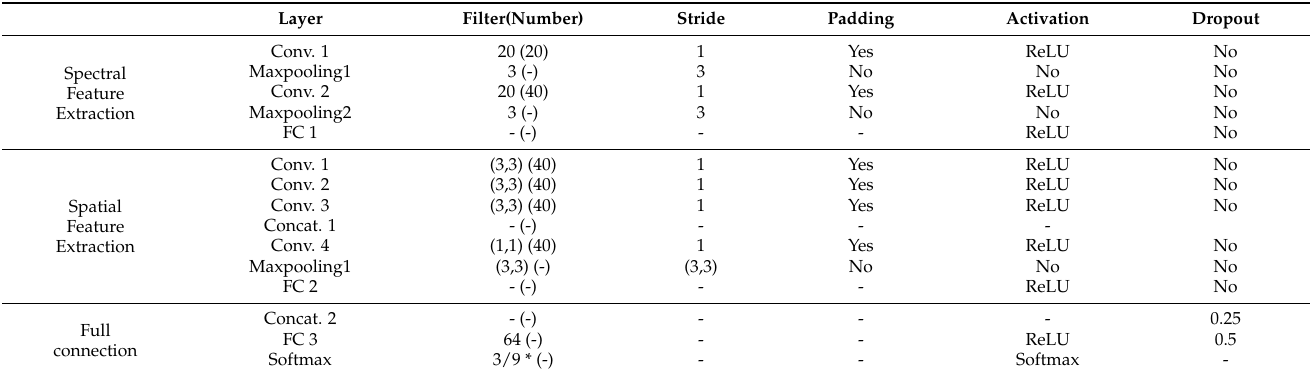
Table 1. Detailed configuration of the proposed network